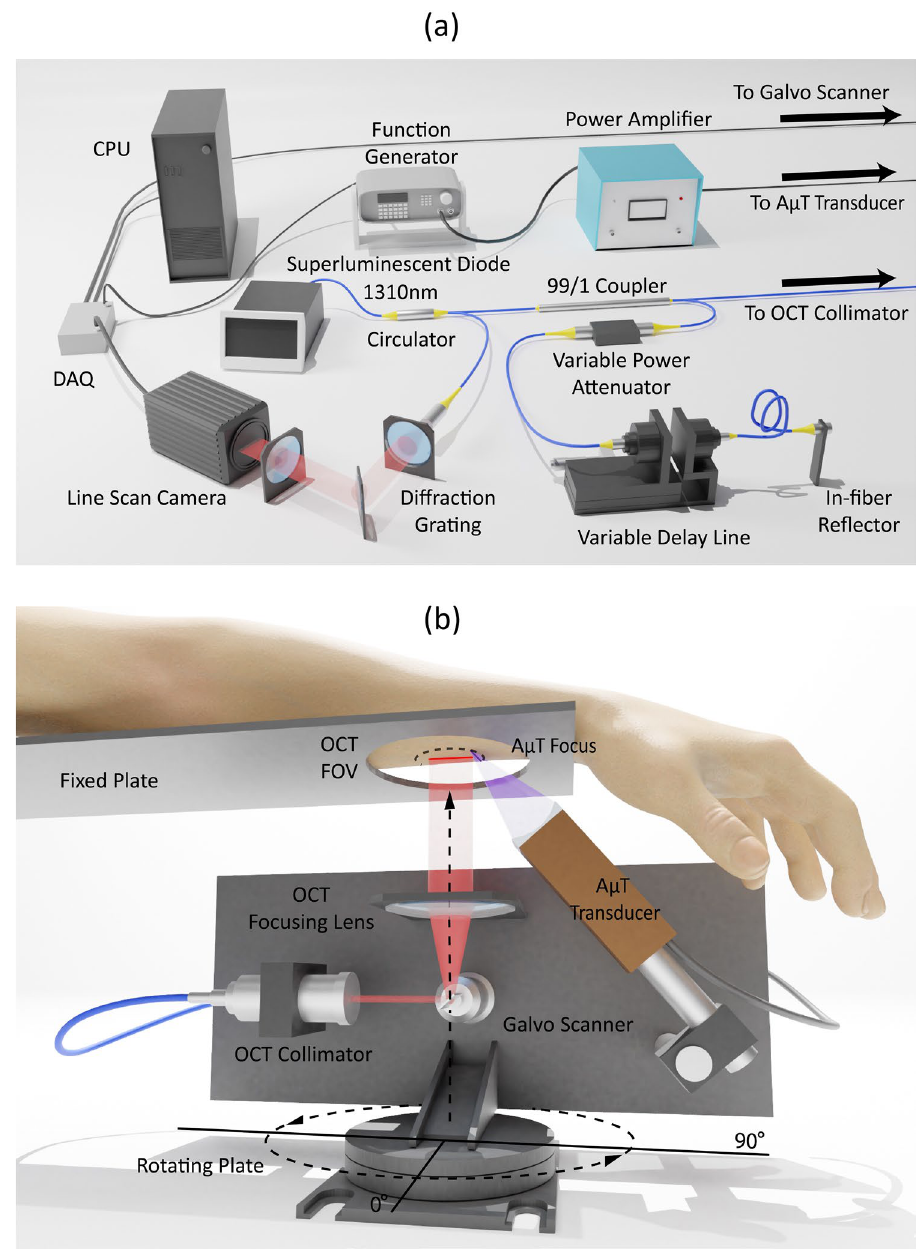
Figure 6. AμT-OCE measurement system: ( a ) schematic of a Fourier-domain OCT system utilizing polarization-maintaining fibers; ( b ) schematic of in vivo AμT-OCE measurement of mechanical wave propagation over the surface of skin for healthy volunteers. Rayleigh waves were excited with a cylindrically focused air-coupled transducer 18–20 . In-plane rotation of the measurement arm was used to track wave propagation in different directions over the skin